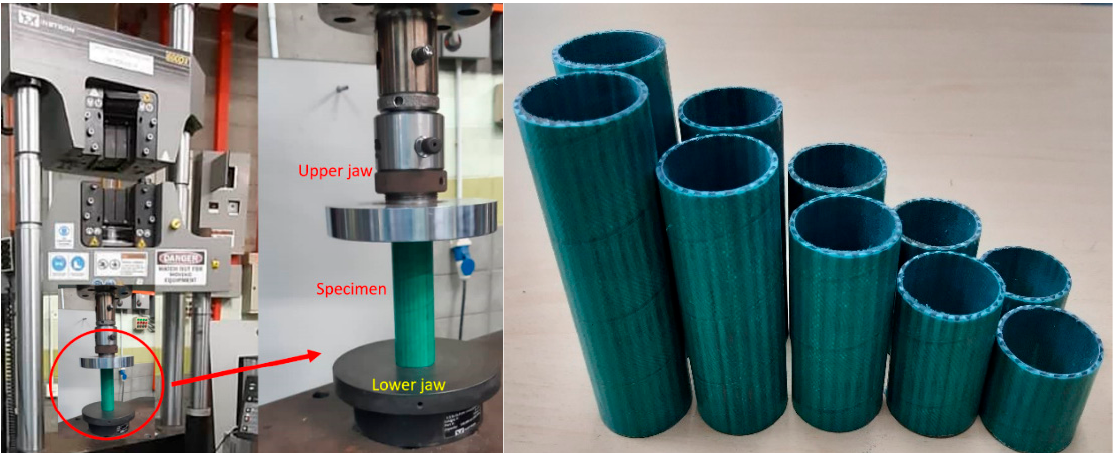
Figure 2. Setup of experiment for compression loading test.